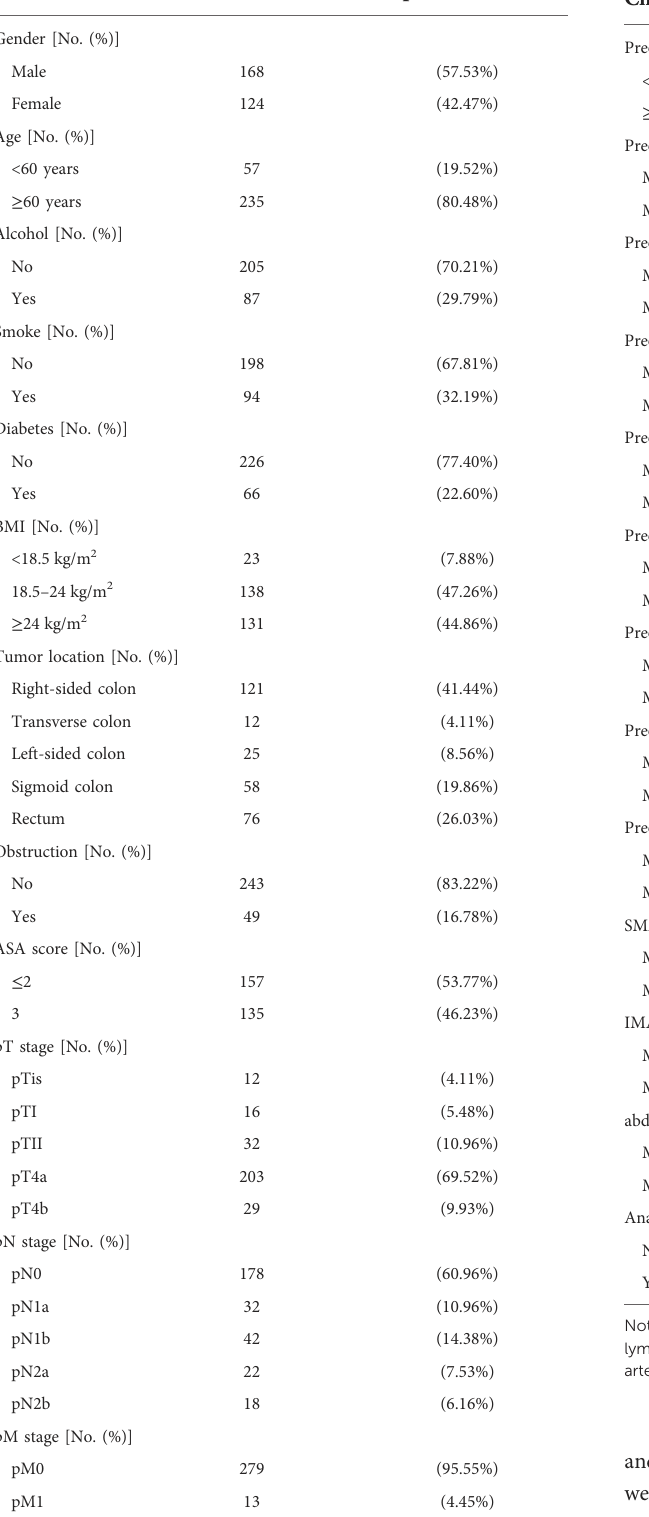
TABLE 1 Clinicopathologic characteristics of all patients.